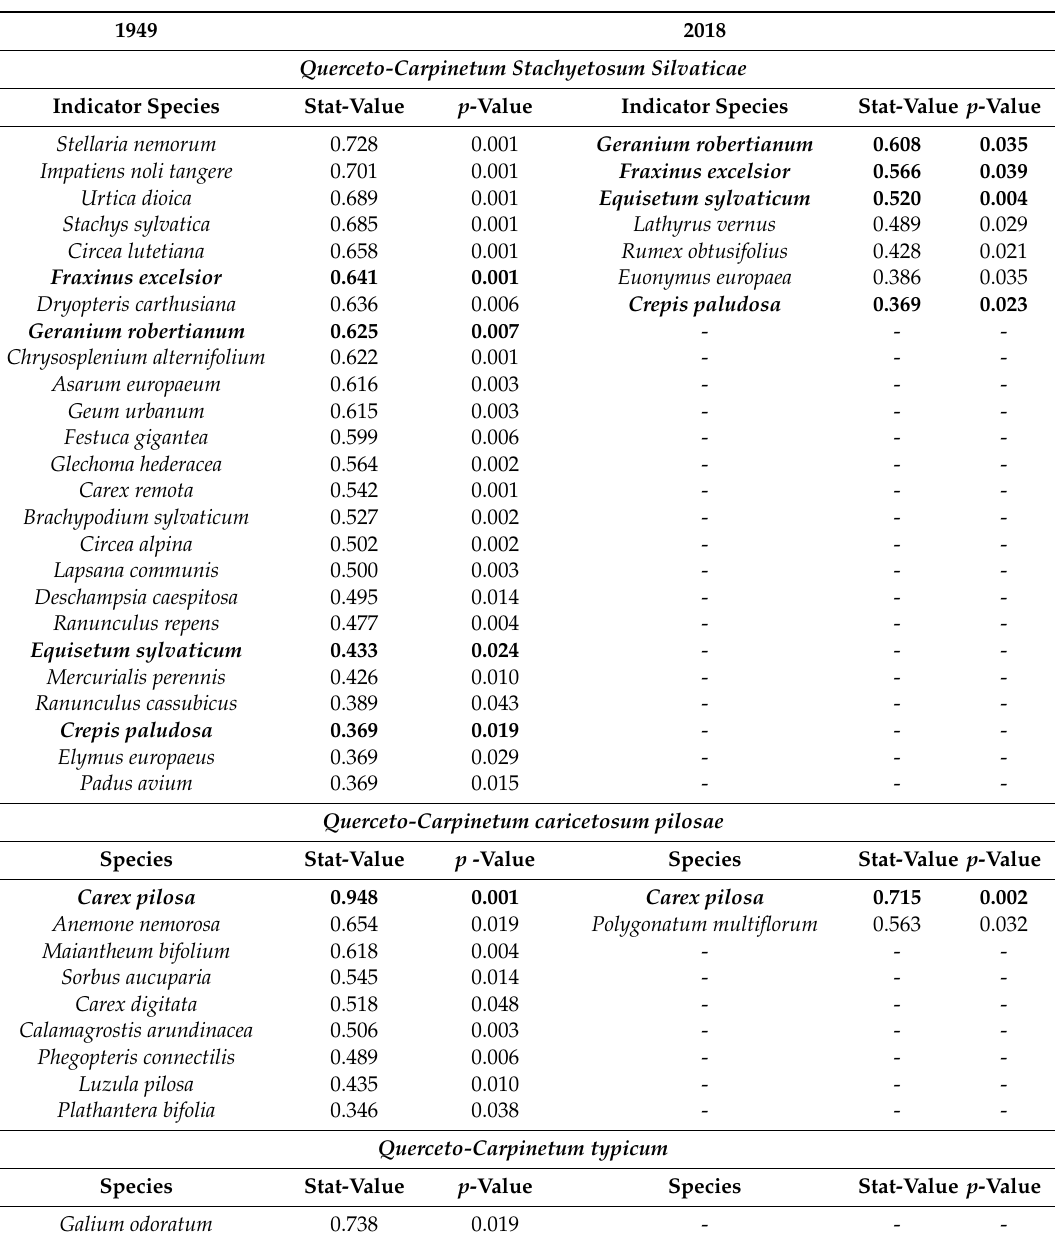
Table 2. List of indicator species for three types of oak–lime–hornbeam forest: Querceto-Carpinetum stachyetosum silvaticae , Querceto-Carpinetum caricetosum pilosae , and Querceto-Carpinetum typicum in two observation periods 1949 and 2018 (based on analysis of indicator species from the “indicspecies” R package). Stat-value—association value based on [49]; boldface—species that were indicators in 1949 and